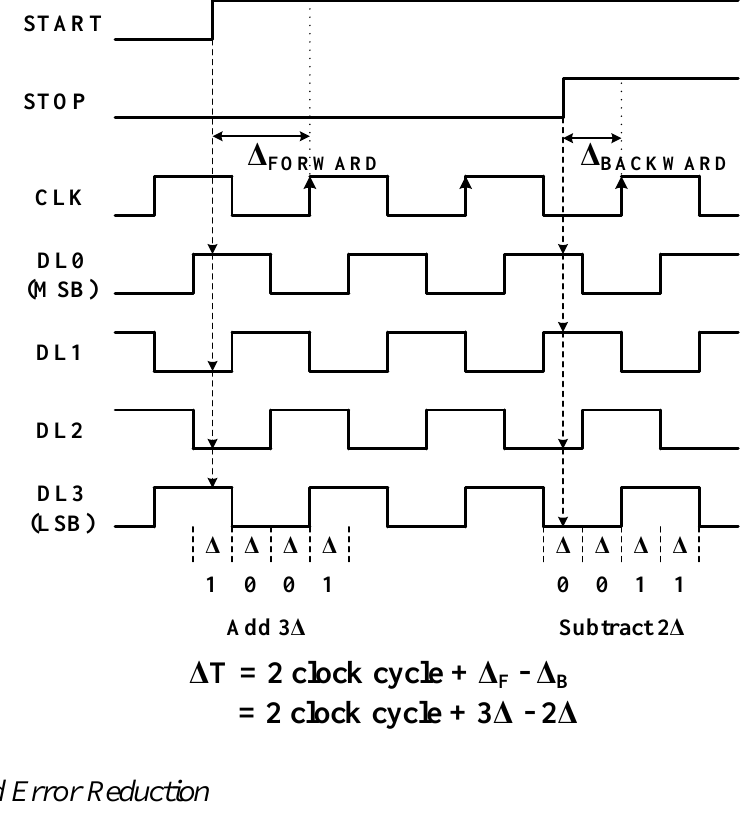
Figure 10. Example of fine TDC operation (with 4 delay cells). The real design as 16 delay